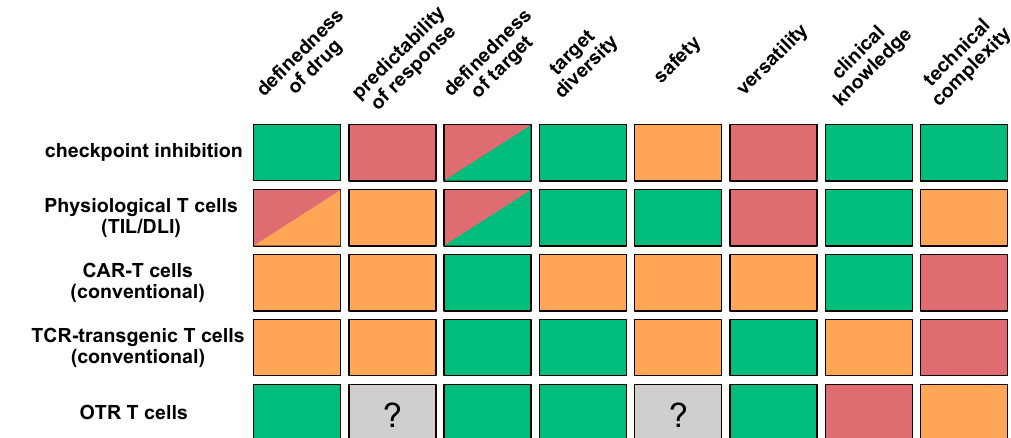
Figure 1. Advantages and challenges of T-cell-based immunotherapies. Checkpoint inhibition, non-engineered T cells, chimeric antigen receptor (CAR) T cells, T-cell receptor (TCR) transgenic T cells, and orthotopic TCR replacement (OTR) T cells differ in the fundamental characteristics of therapies. Colors indicate the degree of experience, benefit, or feasibility depending on the category (green: advantageous, yellow: medium, red: disadvantageous, gray: unknown). Given its novelty, clinical knowledge is limited for OTR T cells. OTR does, however, bear the potential to recombine many of the individual advantages of alternative strategies.